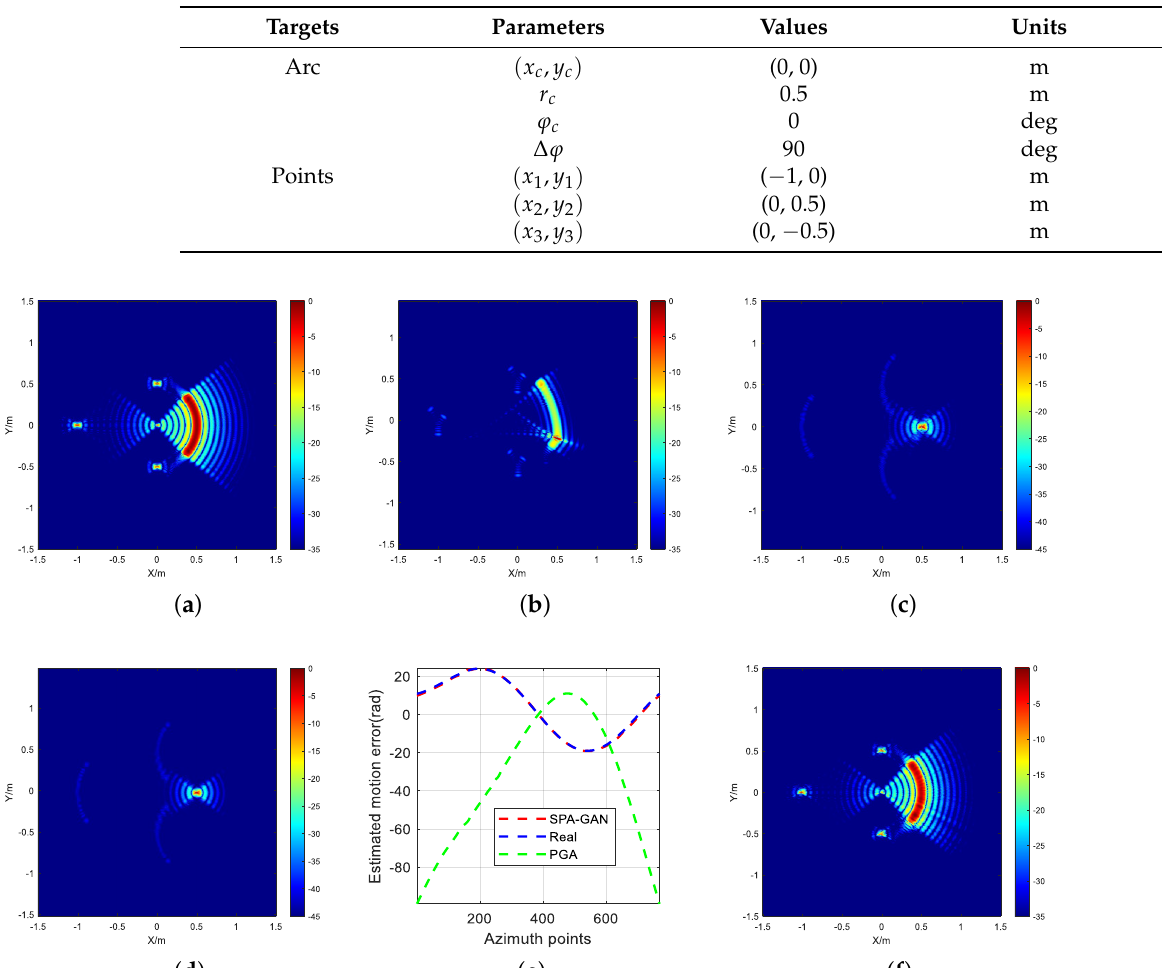
Table 2. The parameters of targets in Figure 9.